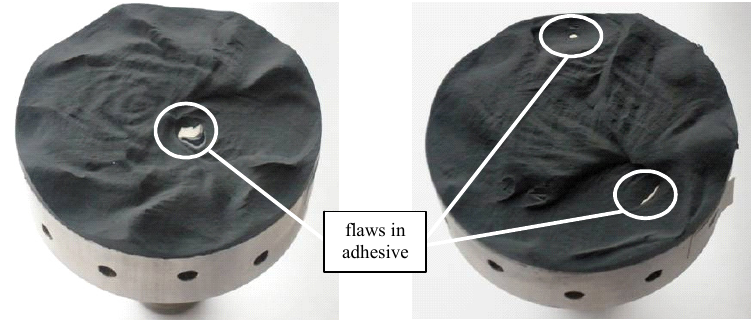
Figure 4: Specimens test 4 and